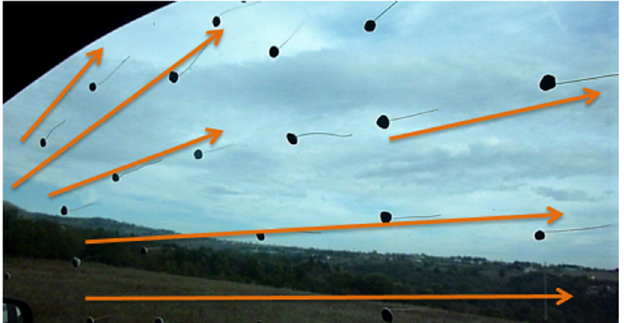
Fig. 10. Photography from an experiment we conducted in a real car, driving at 90 km/h Q5 on a straight road. Little cotton threads had been previously stuck on the outside surface of the window. They show the direction of the local wind. On the picture, orange arrows are added for a better visualization of the direction of